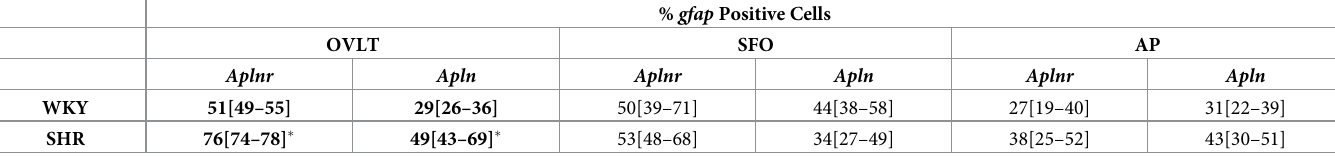
Table 2. The percentage of gfap positive cells co-localizing with aplnr or apln in the OVLT, SFO and AP of WKY rats and